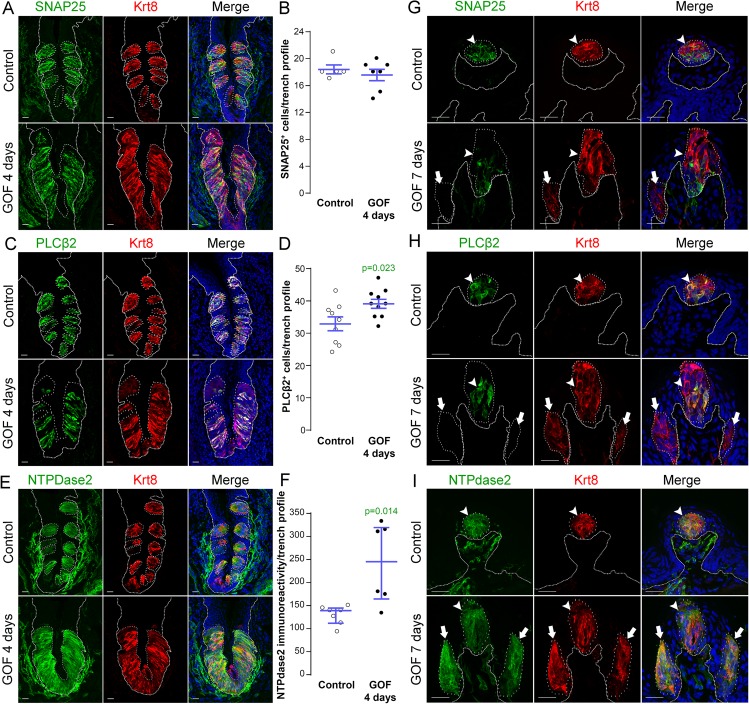
Stabilization of β-catenin in Krt5+ progenitors induces primarily Type I cell differentiation in CVP, FFP and anterior lingual epithelium.
A,B. SNAP25+ Type III taste cells (green) were present in comparable numbers in the CVP of control and mutant mice fed dox chow for 4 days. Note that CVP innervation is also SNAP25+ (green) (Yang et al., 2000). C,D. PLCβ2+ Type II cells (green) were slightly increased in mutant CVP compared to controls. E,F. NTPdase2+ Type I cells (green) cannot be counted (see text), and thus were quantified via measurement of NTPdase2 corrected fluorescence intensity, revealing a 2-fold increase in NTPdase2+ signal in mutant compared to control CVP, accounting for the majority of expanded Krt8+ cells (red in all panels). G. In the anterior tongue of mice fed doxycycline chow for 7 days, endogenous Krt8+ taste buds within FFP (red, white arrowhead) contained SNAP25+ Type III cells (green), while ectopic Krt8+ taste buds (red, white arrow) were devoid of SNAP25+ cells. H. Endogenous FF taste buds house numerous PLCβ2+ Type II taste cells (green, white arrowhead), while ectopic PLCβ2+ cells were not detected in ectopic taste buds (* indicates a PLCβ2-negative ectopic taste bud). I. Ectopic taste buds within FFP of mutants (white arrows), like endogenous FF taste buds (white arrowhead) were always NTPdase2+ (green). Nuclei were counterstained with DRAQ5 in blue. Representative stack images are made of 14 compressed 0.75 μm-thick optical sections. N = 3 control and 3 mutant mice. B,D: Student’s t-test; F: Mann and Whitney test. Data are represented as a scatter plot (individual symbols), and mean ± SEM (blue bars), except F (median with interquartile range). Dotted line delineates the basement membrane. Scale bars = 20 μm.